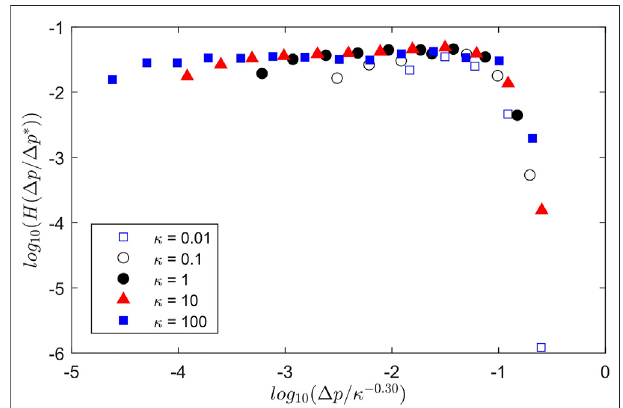
FIGURE7| The dependence ofthe crossover function H ( Δ p / Δ p *)ofthe pressure jump distribution in a modi fi ed invasion percolation simulation [63]. For each value of κ , the points represent averages over fi ve independent simulations on 200 × 1,500 lattices. The scaling exponent 0.30 ≈ 1/(1 + ] D ). Data is taken from